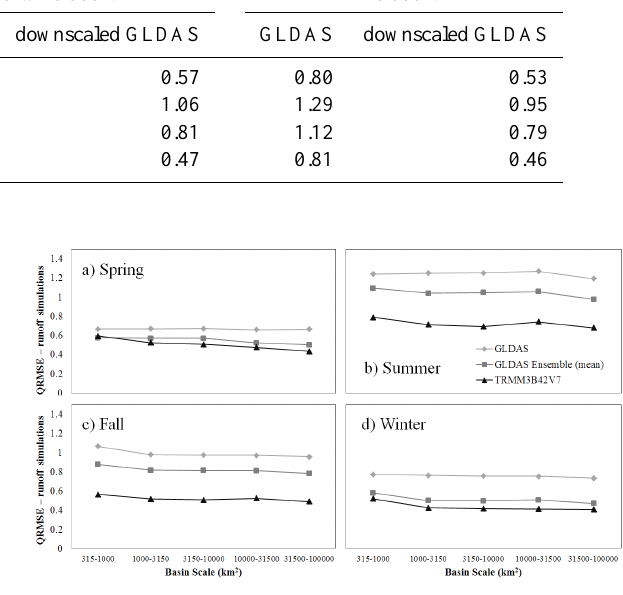
Figure 12. QRE error metric determined conditional to reference runoff values exceeding their 90th percentile. The horizontal axis indicates basin-scale categories presented in Table 2. Results are presented for spring (upper left panel), summer (upper right), fall (lower left), and winter (lower right) seasons.